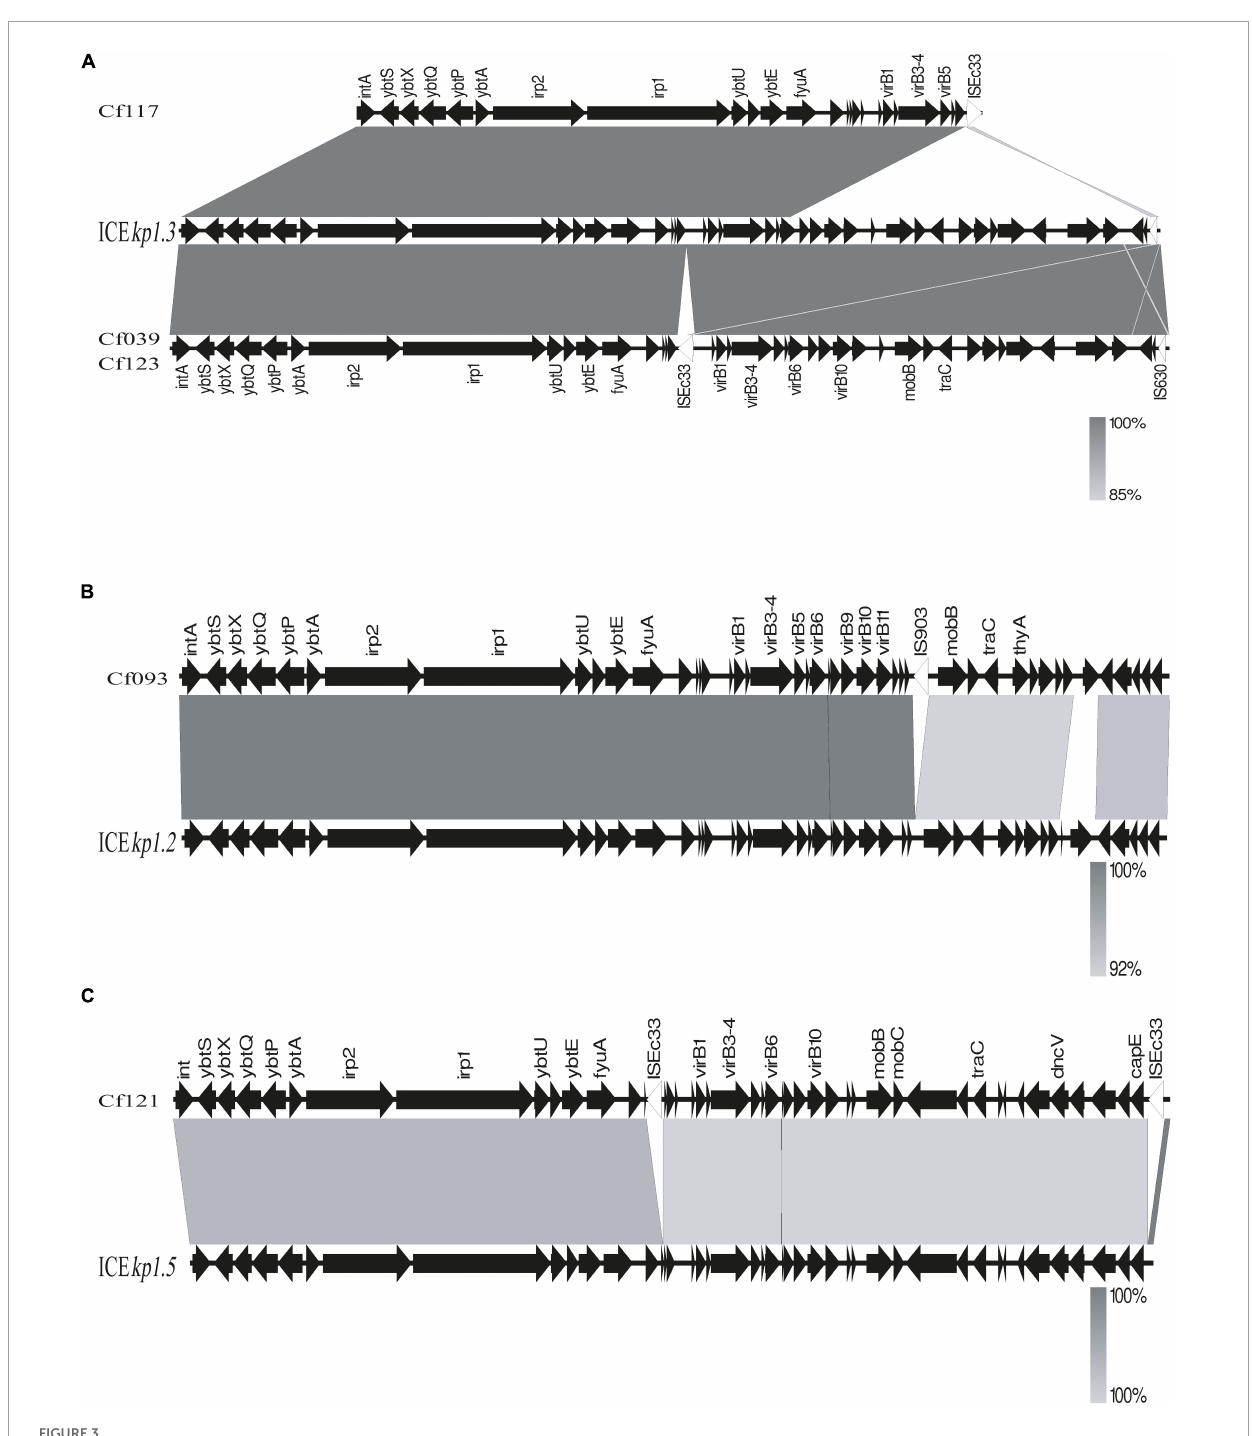
FIGURE3 Linear comparison of ICE kp sequences in five C . freundii . Sequences were aligned to one another using Easyfig. Genes are denoted by arrows with a gradient from gray (low identity) to black (high identity). (A) Genomic comparison of Cf117, Cf039, Cf123 with ICE kp 1.3, (B) Cf093 with ICE kp 1.2 and (C) Cf121 with ICE kp